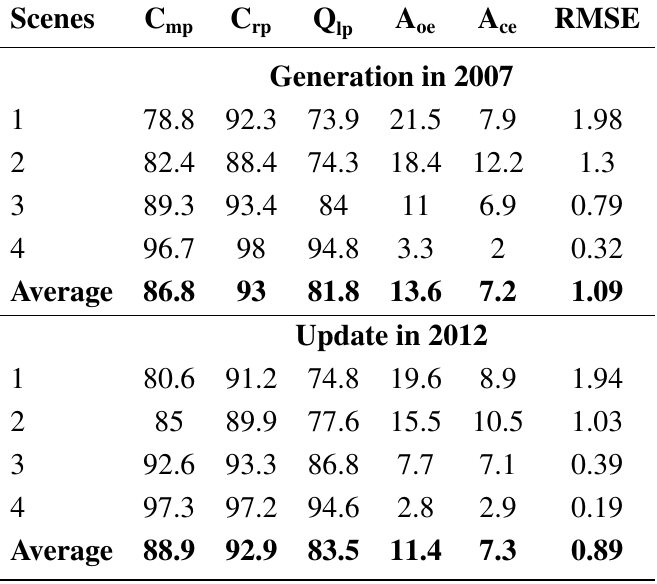
Table 9. Pixel-based accuracy of the building map database. C C = correctness, Q rp percentage and RMSE in